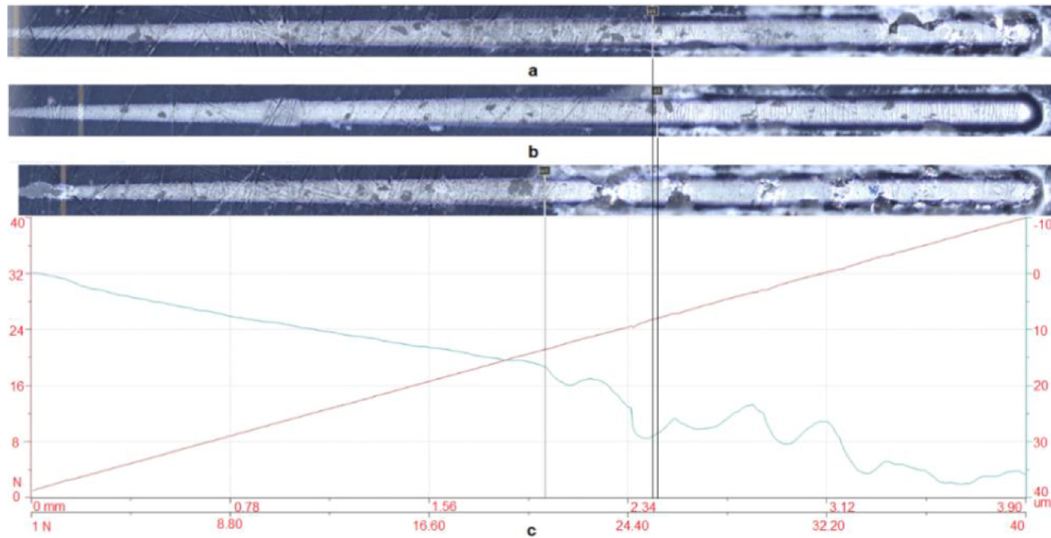
Fig. 4. Scratch test on the substrate manufactured by rolling process from Ni based superalloy and coated by EB-PVD with a multilayer fi lm of